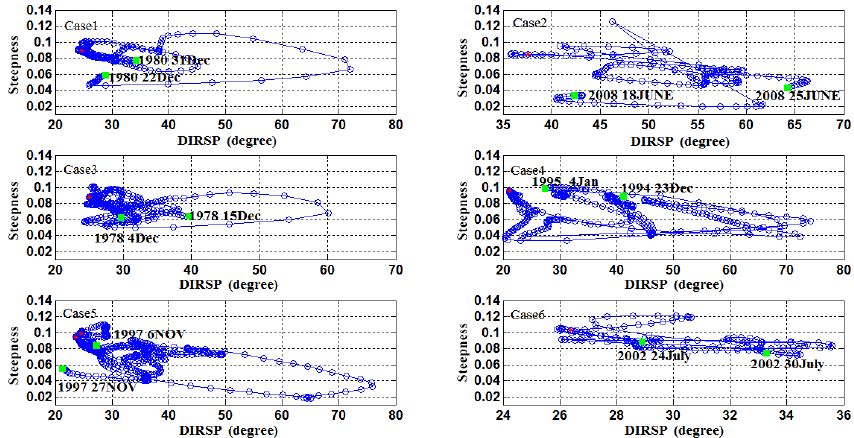
Figure 6. Joint scatter plot of directional spreading and steepness by 1h during 7–20 days around the freak waves’ occurrence time (cases 1– 6); red stars refer to the freak wave occurrence time, green rectangles refer to the start and end